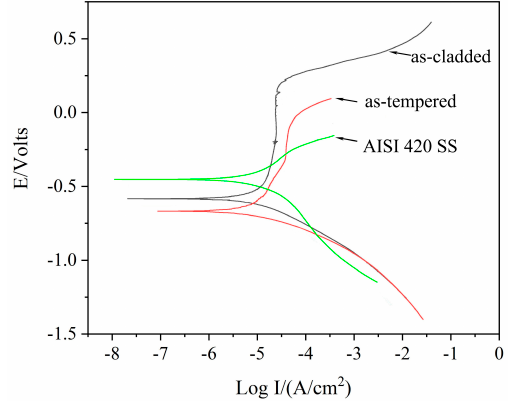
Figure 8. The polarization curves of the pre- and post-tempered specimens.